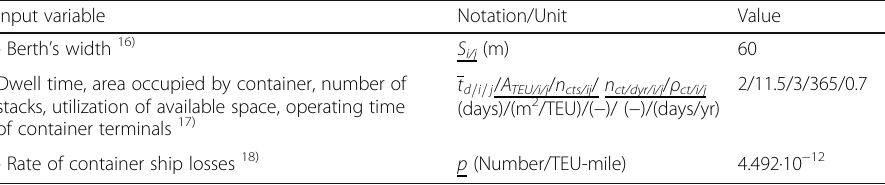
Table 1 Inputs for application of the models of indicators of performances of the given trunk line/route 1)